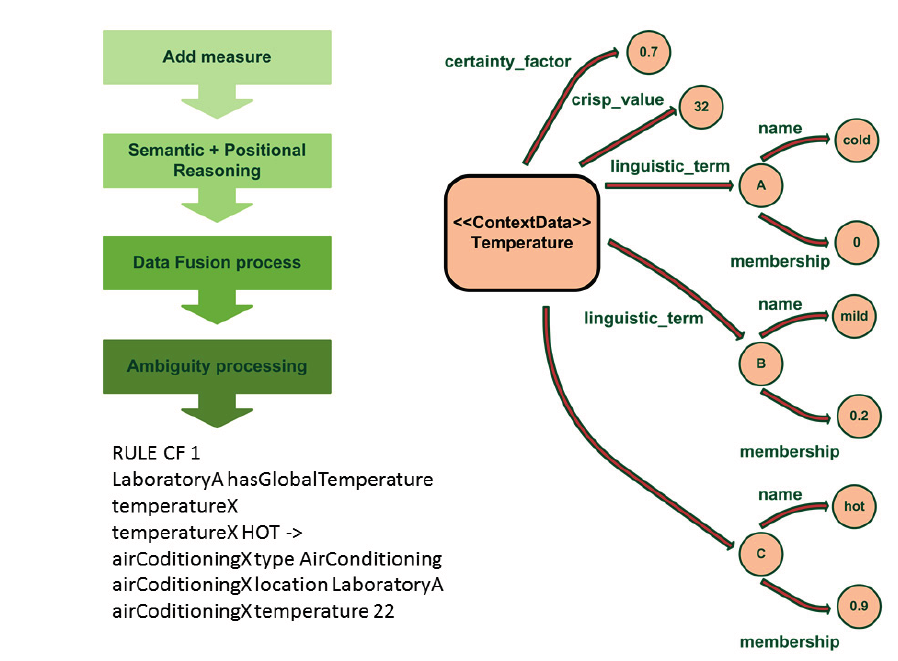
Figure 5. Hybrid reasoner uncertainty management and AMBI2ONT